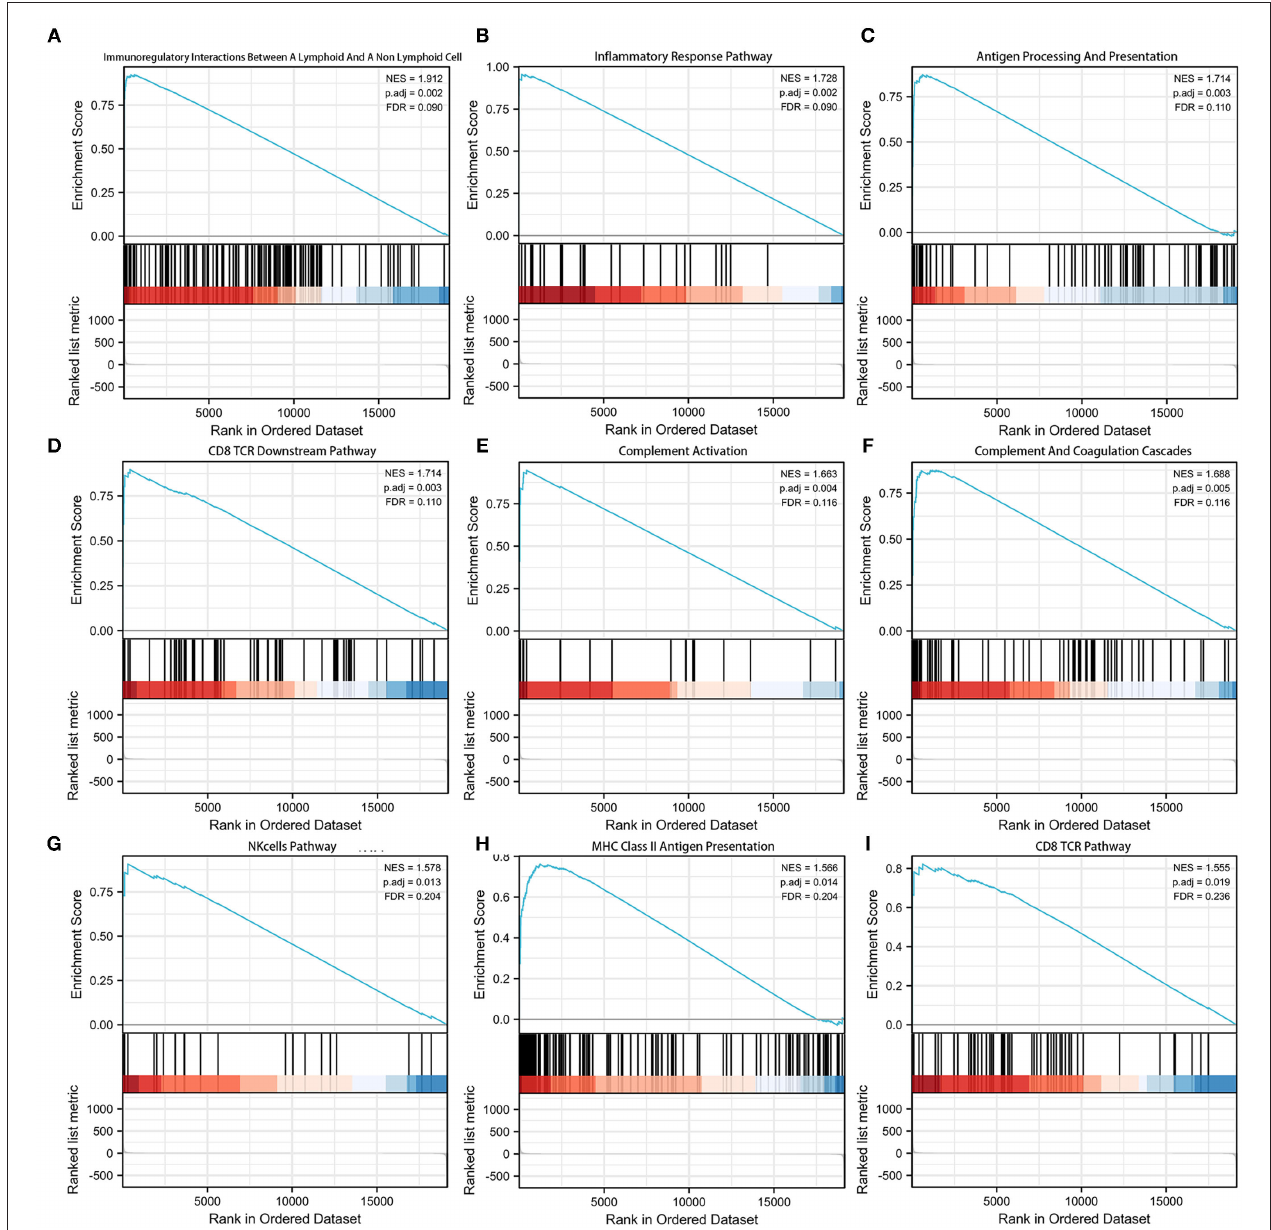
FIGURE 5 | Gene set enrichment analysis (GSEA) of the pyroptosis-related lncRNA prognostic signature. (A) Immunoregulatory interactions between a lymphoid cell and a non-lymphoid cell. (B) Inflammatory response pathway. (C) Antigen processing and presentation. (D) CD8TCR downstream pathway. (E) Complement activation. (F) Complement and coagulation cascades. (G) NK cell pathway. (H) MHC class 1II antigen presentation. (I) CD8TCR pathway. OC who may benefit from immunotherapies of PD-1,